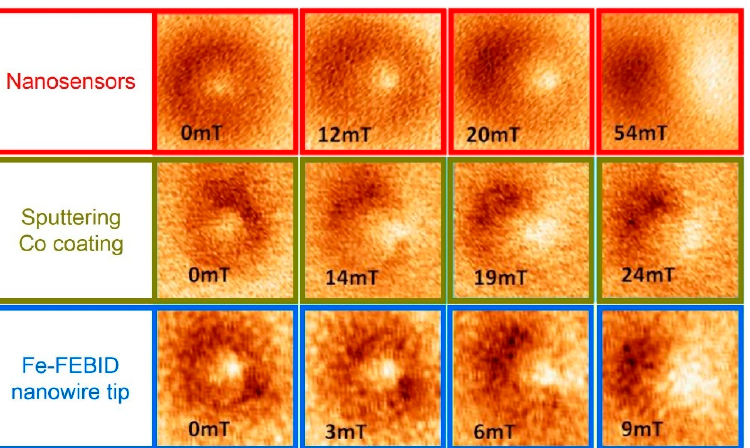
Figure 7. MFM images of permalloy nanodots as a function of the in-plane magnetic field, obtained with a commercial magnetic tip by Nanosensors TM , a sputtered Co-coated tip and an Fe-FEBID nanowire tip. All image sizes are 250 × 250 nm 2 . Reproduced from [42] with permission from the Royal Society of Chemistry.